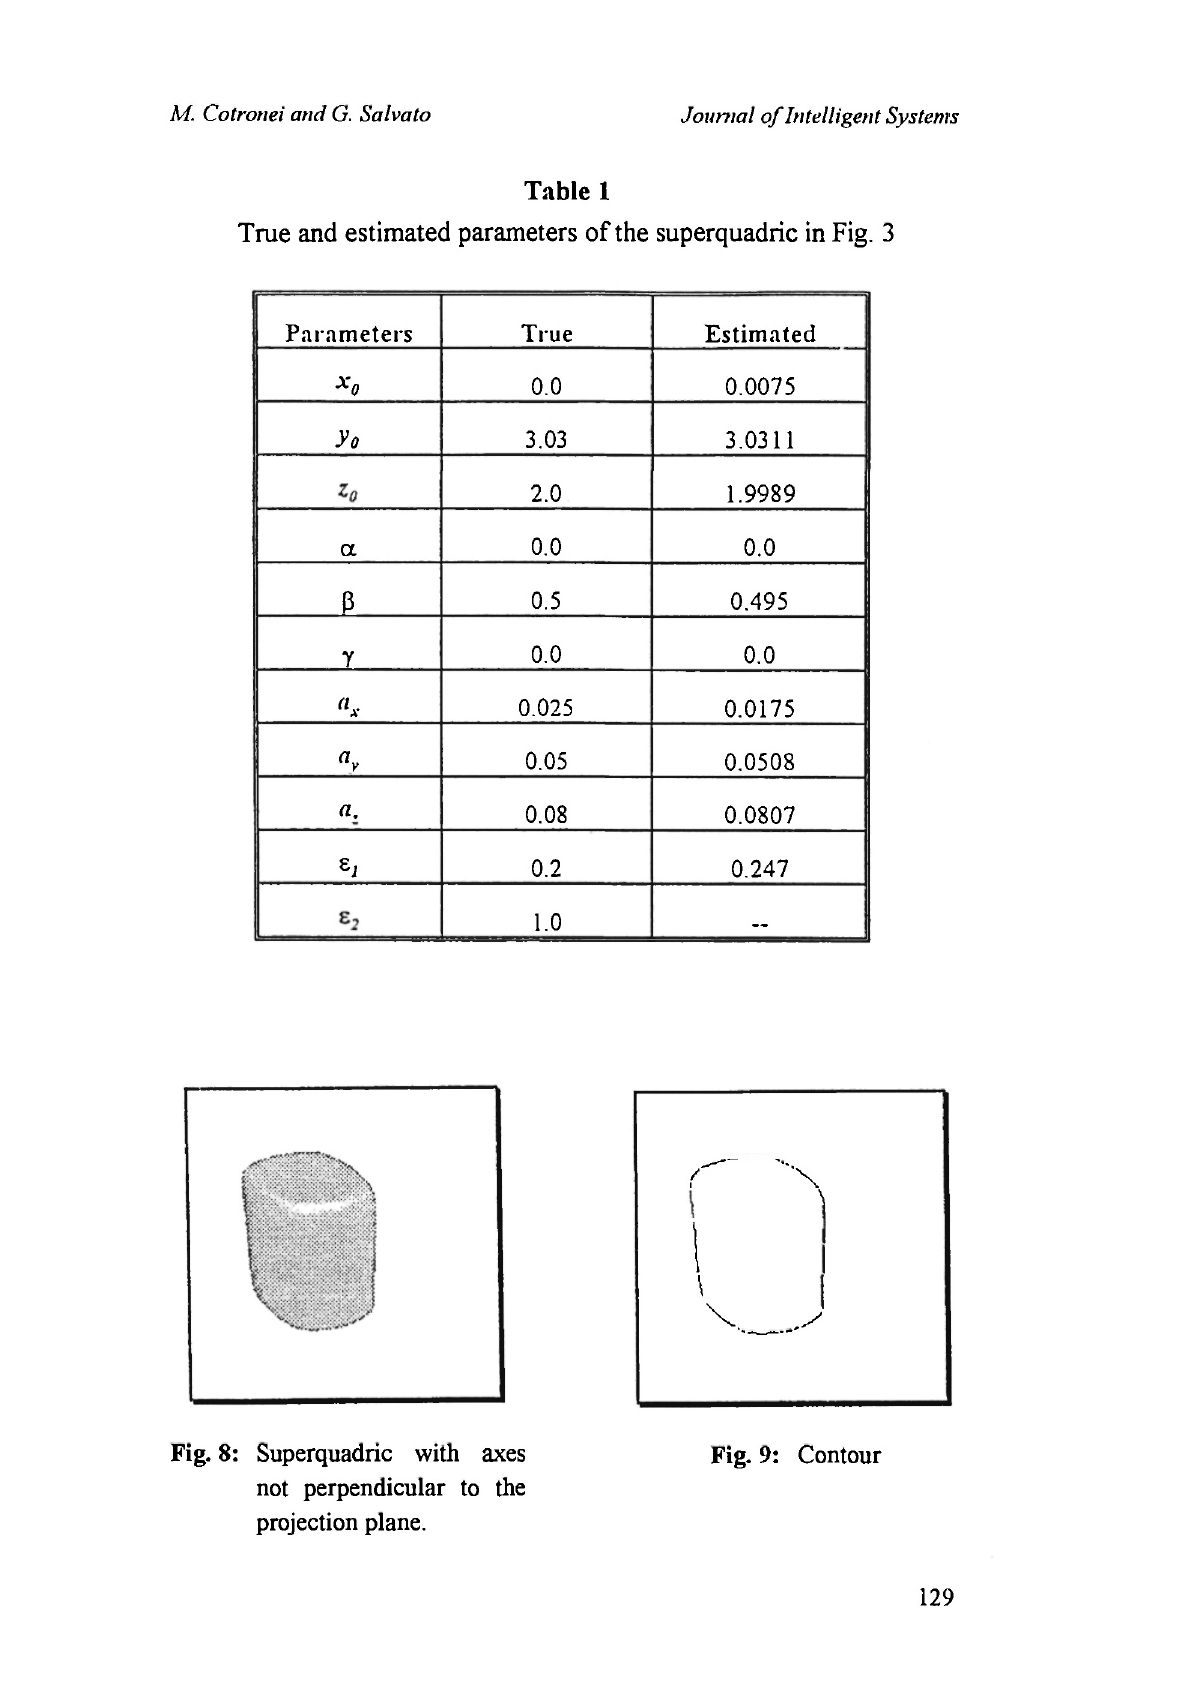
Fig. 8: Superquadric with axes Fig. 9: Contour not perpendicular to the projection